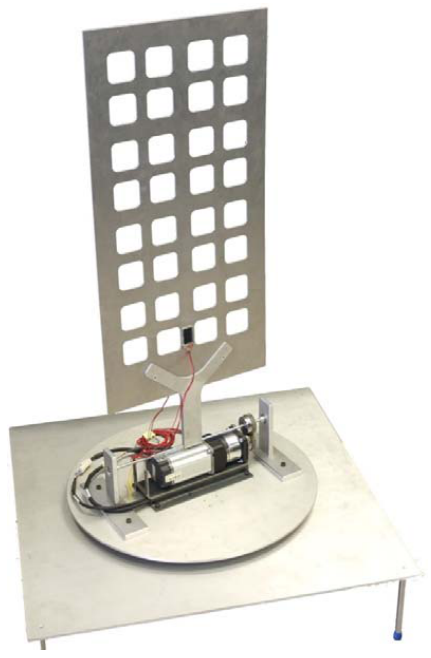
Figure 7. Hardware photograph representing a large flexible structure in experiments. Table 1. Properties of the flexible plate.